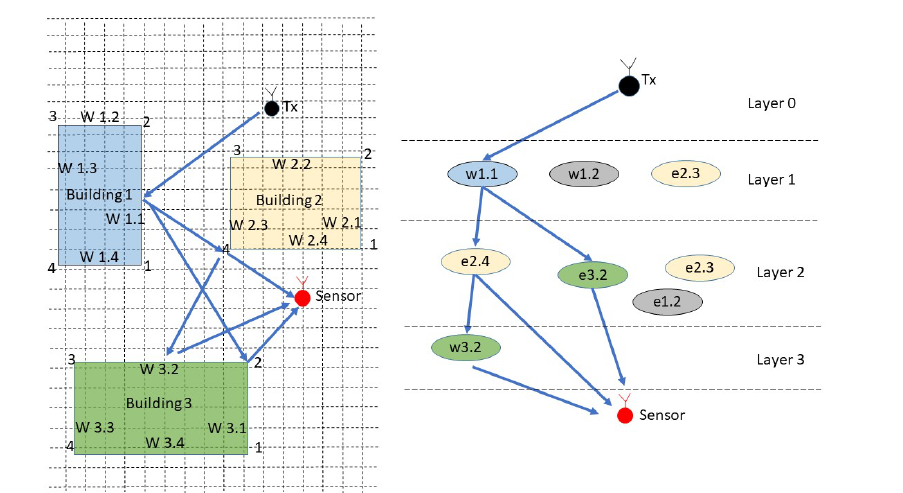
Figure 9. Schematic representation of walls and edges in ray-tracing